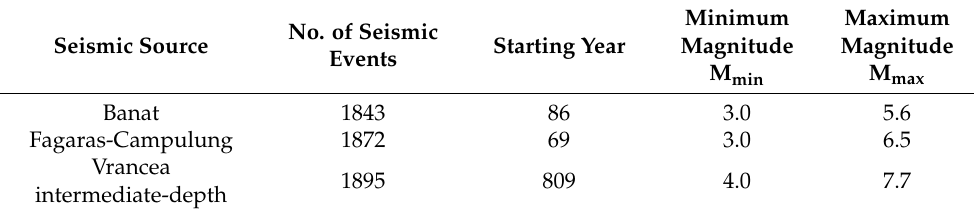
Table 1. Characteristics of the earthquake catalogs for the three considered seismic sources.